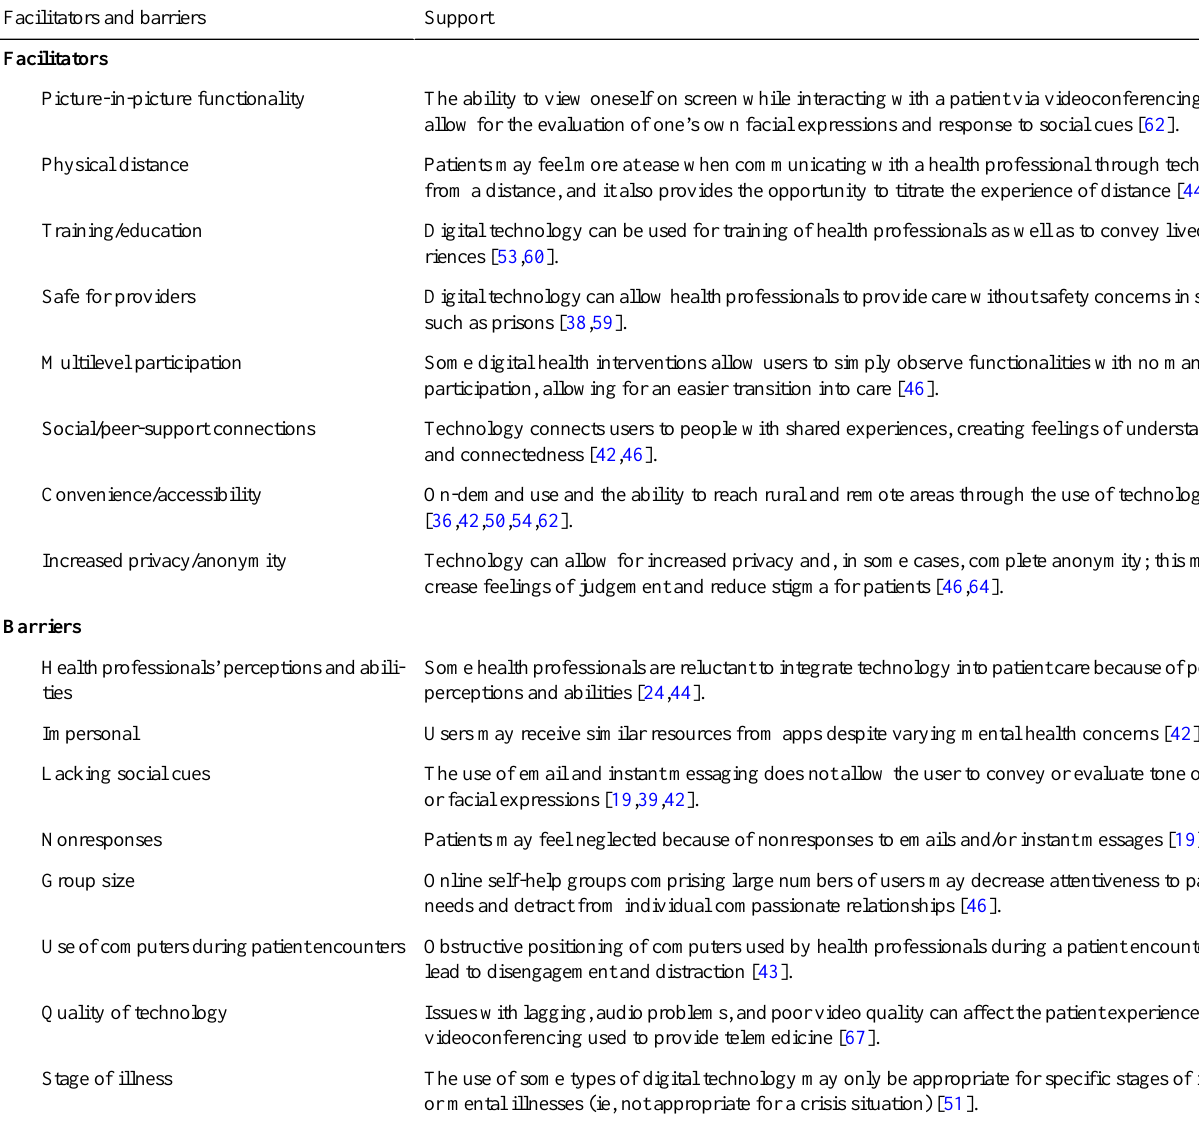
Table 5. Facilitators of and barriers to delivery of compassionate care through digital technology. SupportFacilitators and barriers Facilitators